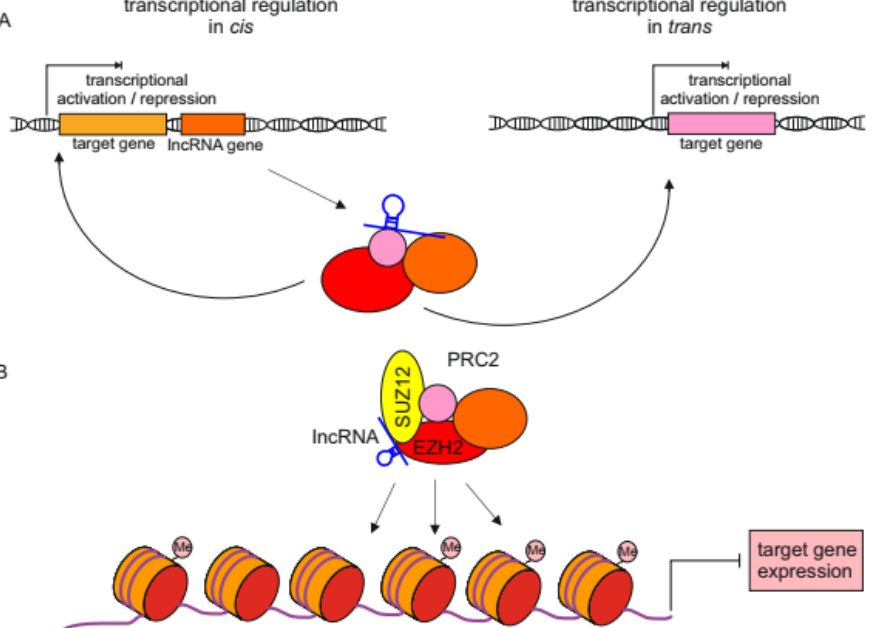
Figure 1. The mechanisms of transcription regulation mediated by lncRNAs in the nucleus. ( A ) lncRNA bind to the effector protein complex that activates or represses the expression of target genes. lncRNAs may act in cis, where they regulate the expression of adjacent or proximal genes on the same chromosome, or in trans, regulating distant genes from other chromosomes. ( B ) lncRNAs bind to polycomb repressive complex 2 (PRC2) mostly through EZH2 or SUZ12 protein subunits. This complex facilitates histone 3 lysine 27 (H3K27me3) trimethylation and occupancy of target gene promoter which results in target gene repression.